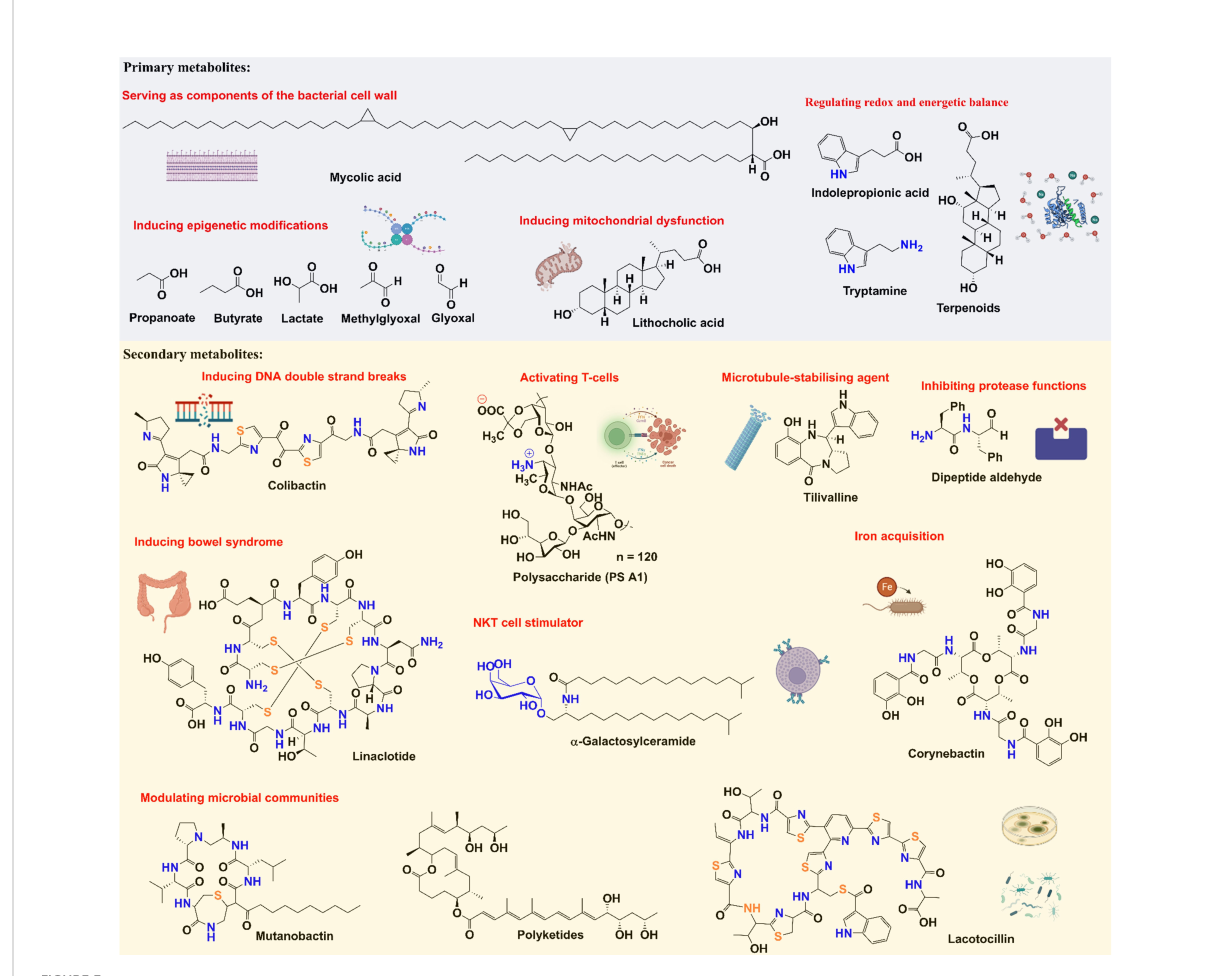
FIGURE 3 Chemical structures and functions of representative metabolites from tumor